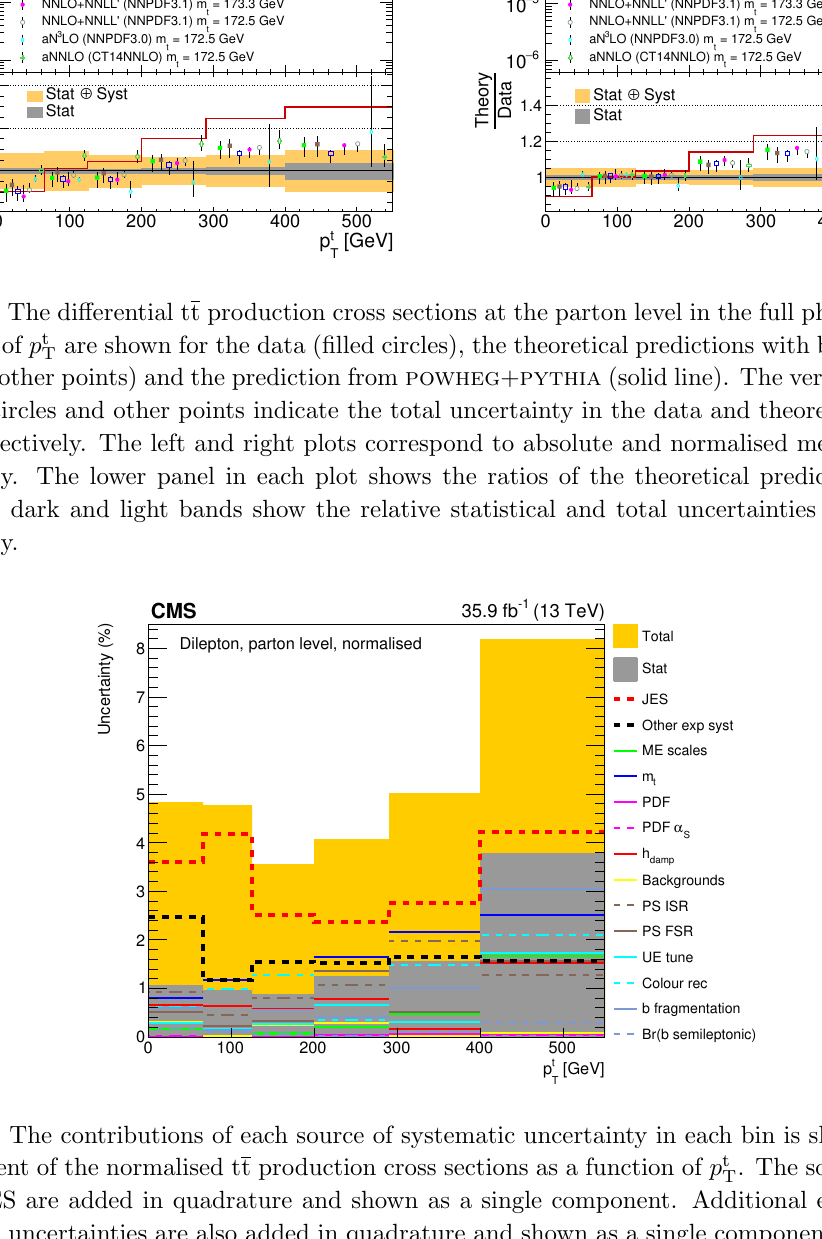
. The sources a(cid:11)ect- T